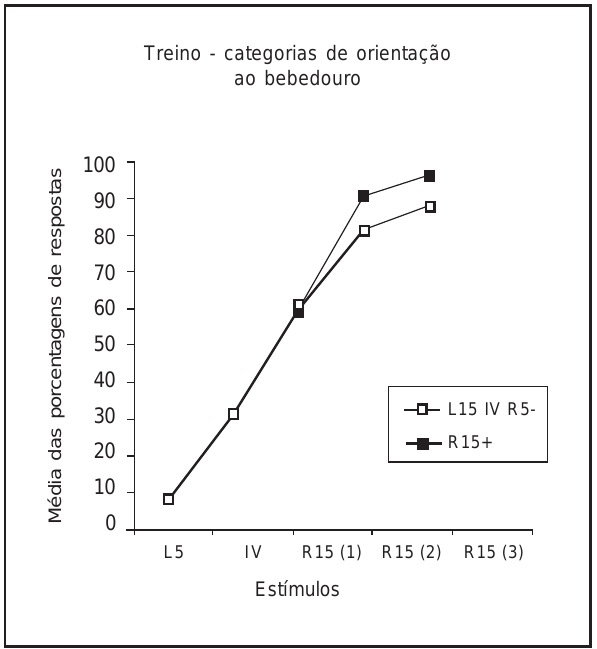
Figura 1b. Médias das porcentagens de resposta das categorias de tipo exploratório agrupadas (locomoção, levantar-se, farejar e farejar próximo ao bebedouro) nas práticas L15 IV T5+ e T5-, durante as 5 últimas sessões da fase de aquisição. L= luz; T=Tom; IV = intervalo vazio; L1(15), L2(15) e L3(15) correspondem a blocos de 5 segundos de